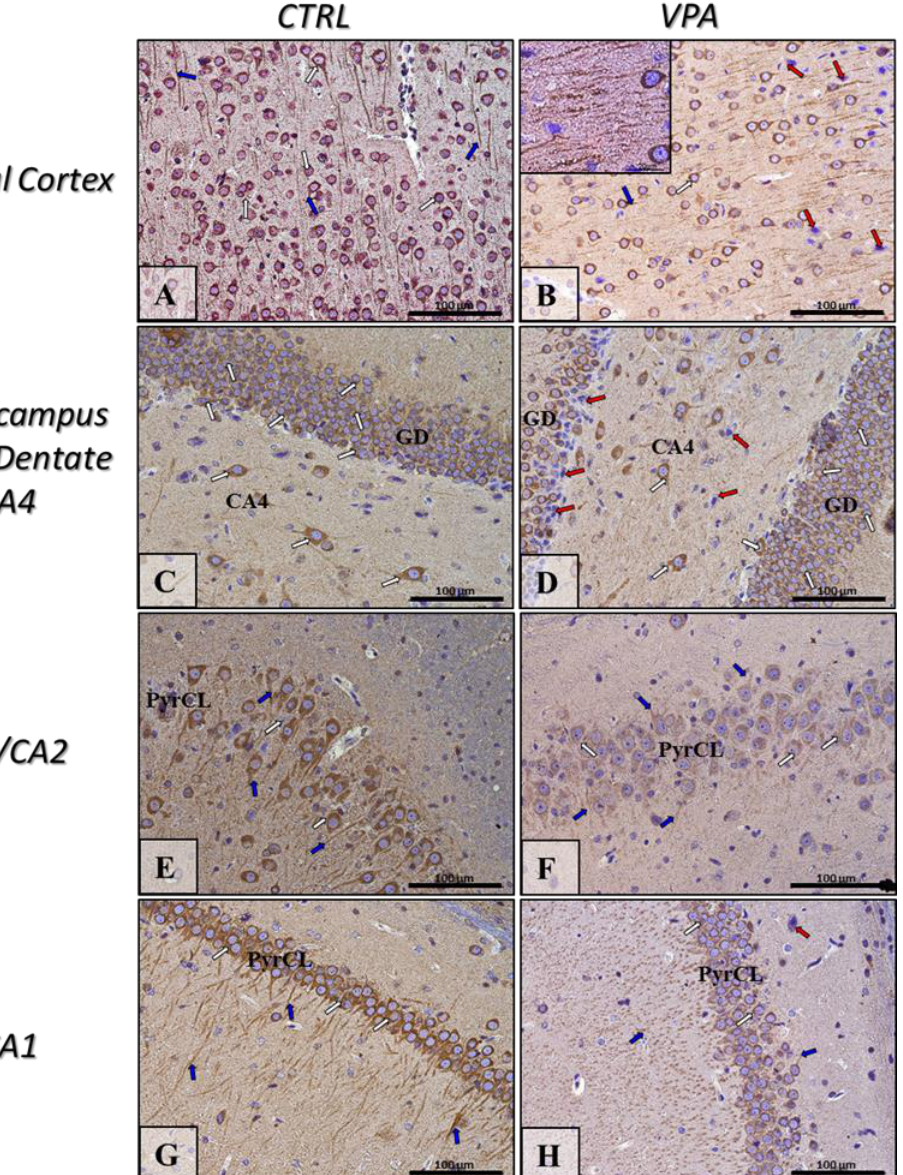
Figure 3. The effect of prenatal exposure to VPA on the immunoreactivity of α / β -tubulin in the rat brain. Representative microphotography showing immunoexpression of α / β -tubulin in the cerebral cortex and hippocampus proper (GD—Gyrus Dentate, CA1-CA4—the regions of Cornu Ammonis) of control rats ( A , C , E , G ) and VPA-treated rats ( B , D , F , H ). IHC reaction. Scale bar: 100 µ m and 20 µ m in the insertion of B (objective magnification × 40, × 100, respectively). α / β -tubulin-immunopositive perikaryon (white arrows) and their processes (blue arrows); red arrows— α / β -tubulin-immunonegative neurons with pathologic phenotype (chromatolysis—collapsed cell nucleus as a result of the negatively affected cytoskeletal network because of degradation of Nissl bodies and disturbances of cell metabolism); PyrCL—Pyramidal Cell Layer of CA1-CA3 regions. Representative pictures from n = 11 (CTRL) and n = 9 (VPA) independent experiments in both the hippocampus and cerebral cortex are presented.